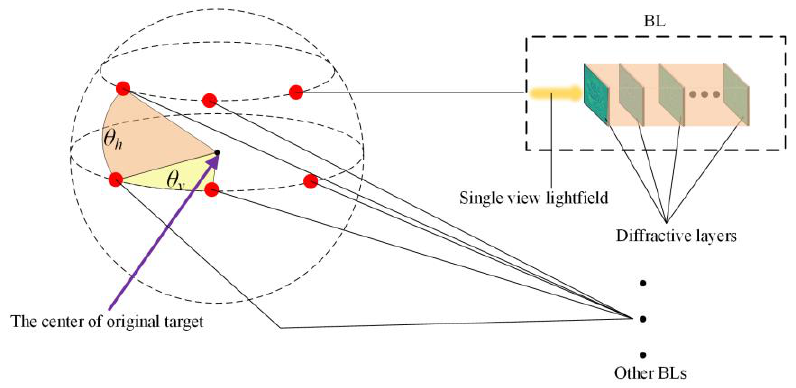
Figure 4. Typical distribution character of the BLs.